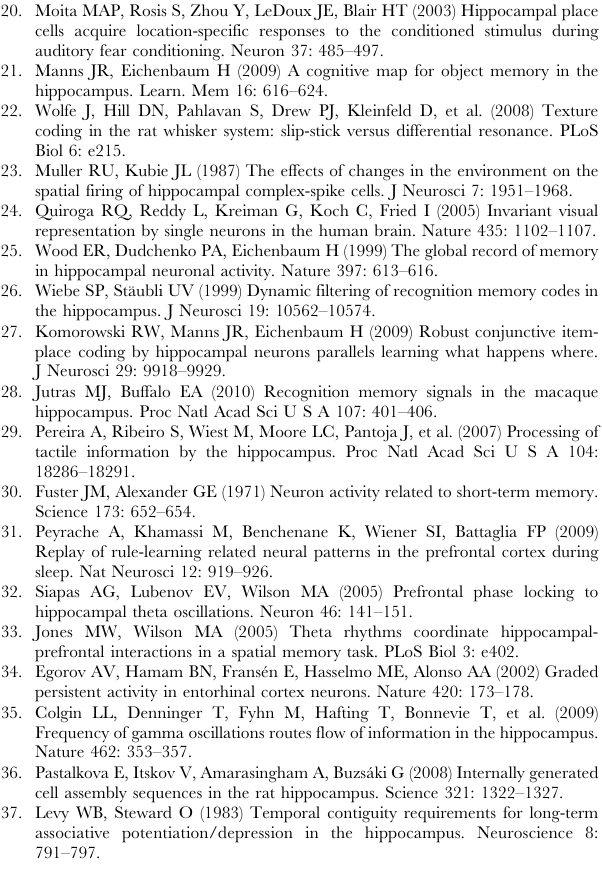
Figure S8 Representation of texture without reward location. Presence of a texture signal does not require the presence of a reward location signal. (A) The firing rates profiles associated with the animal’s selection of the left and right reward locations were overlapping at all times on platform A. (B) Firing rate profiles associated with the left reward location on platform A are separated according to the texture present on each trial; now stimulus-specific activity can be discerned. (C) Temporal profile of information about reward location carried by neuronal firing rate; values were close to zero (black). In contrast, large quantities of texture information (blue) were present both during contact time and during reward collection. Figure S9 Independence of populations recruited to encode texture in different locations. In the two-platform task, neurons were tested for the presence of texture information on four occasions (the left and right texture pairs on platform A, and the left and right texture pairs on platform B). We asked whether the presence or absence of information about texture within one pair influenced the probability that a neuron would carry information about texture within any other texture pairs. Black bars indicate the numbers of neurons that carried a given number of texture signals, from 0 to 4. Of all 170 ‘‘texture neurons’’, the majority (147) distinguished between only one texture pair on only one platform (for example, those neurons illustrated in Figure 3). Just 24 of 170 carried signals for more than one texture pair. The white bars indicate the count of neurons that would be expected to carry a given number of texture signals if